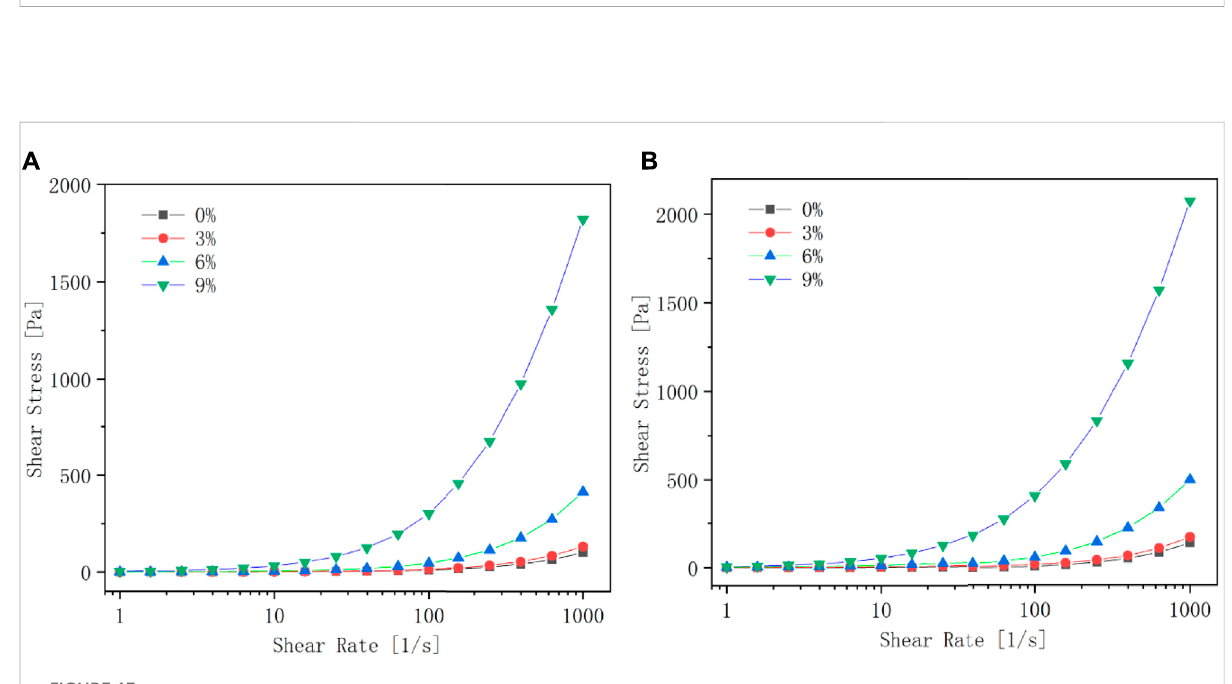
FIGURE 13 Flow curves of kerosene-based magnetic fl uids with different evaporation rates under different magnetic fi eld strengths. (A) is when the magnetic fi eld strength is 0T; (B) is when the magnetic fi eld strength is